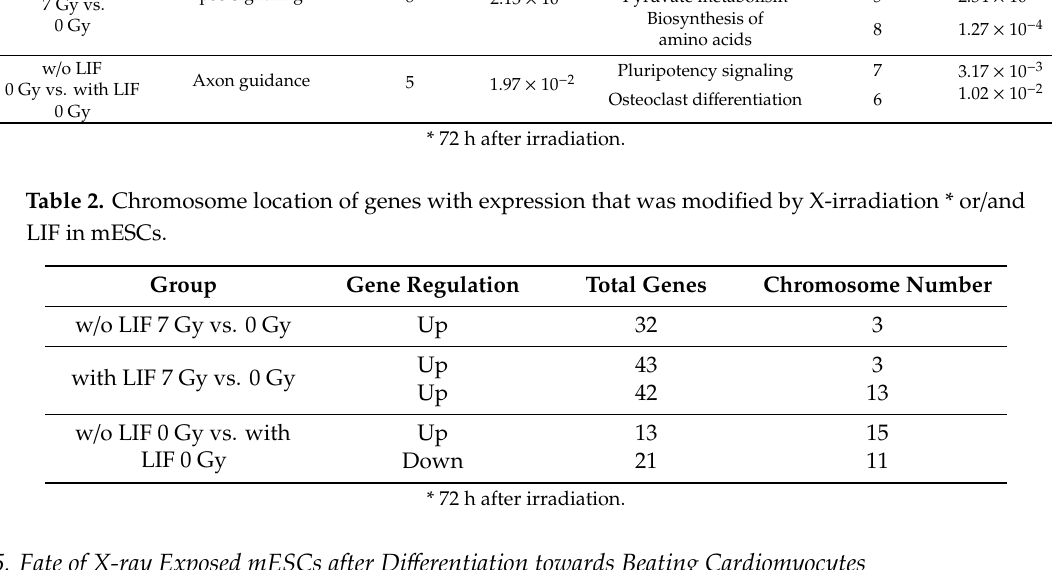
Table 1. Main KEGG pathways influenced by X-irradiation * of mESCs ( ± LIF). Group KEGG Pathway (Up) Total Genes p Value KEGG Pathway (Down) Total Genes p Value p53 signaling w / o LIF 7 Gy vs. 0 Gy with LIF p53 signaling 7 Gy vs. 0 Gy w / o LIF Axon guidance 0 Gy vs. with LIF 0 Gy